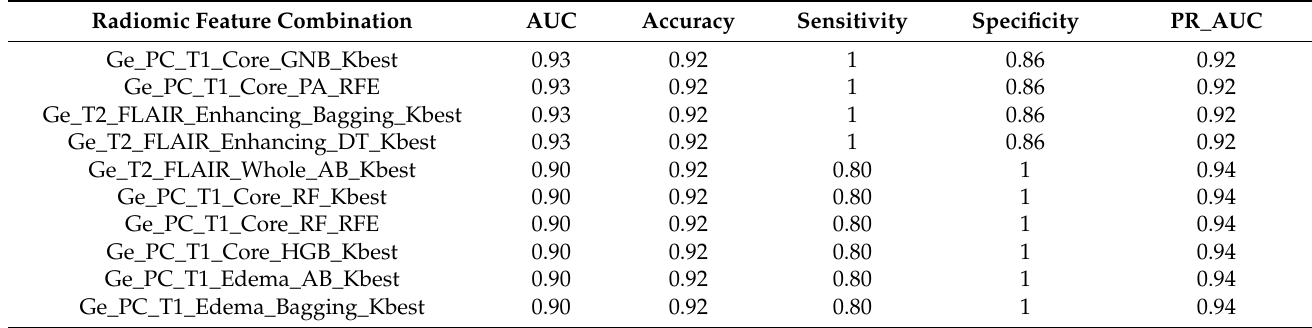
Table 2. Best 10 performances of multi-segmentation approaches, multi-machine learning classifiers, and multi-feature selection algorithms in discriminating IDH-mutant grade 4 astrocytomas from IDH-wild-type GBMs using generated (Ge) data with 80% training set.